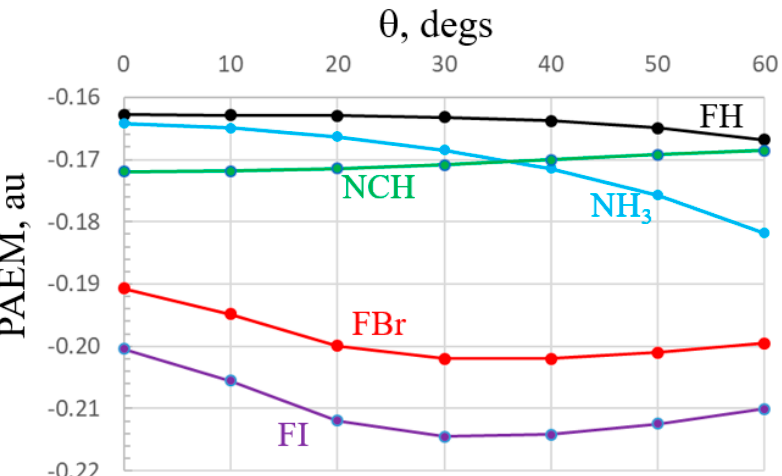
Figure 9. PAEM of indicated monomers, plotted against deviation angle θ from FX axis for acids, NCH axis for NCH, and C 3 symmetry axis of NH 3 . Quantities were evaluated along a circle centered about the X or N atom, with a radius of 3